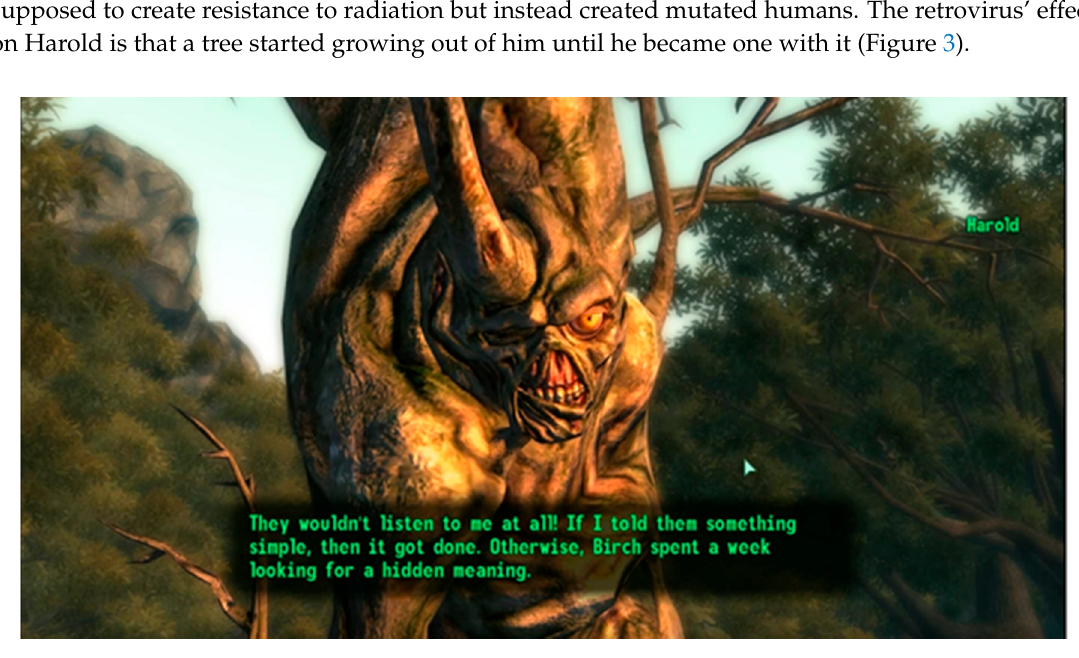
Figure 3. Harold, The One Who Grows, Gives and Guides, talking to the player.